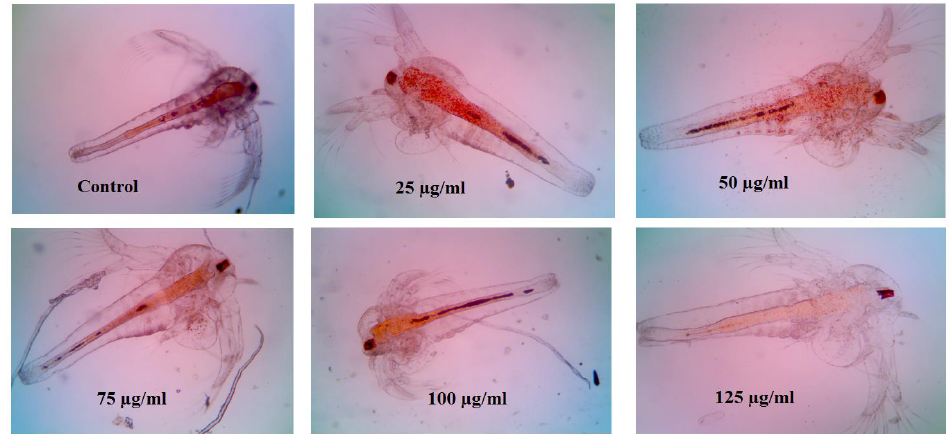
Figure 7. Cytotoxicity evaluation of A. salina nauplii post exposure to MG@Folate ZIF-L nanoframe- works (magnification 10×).